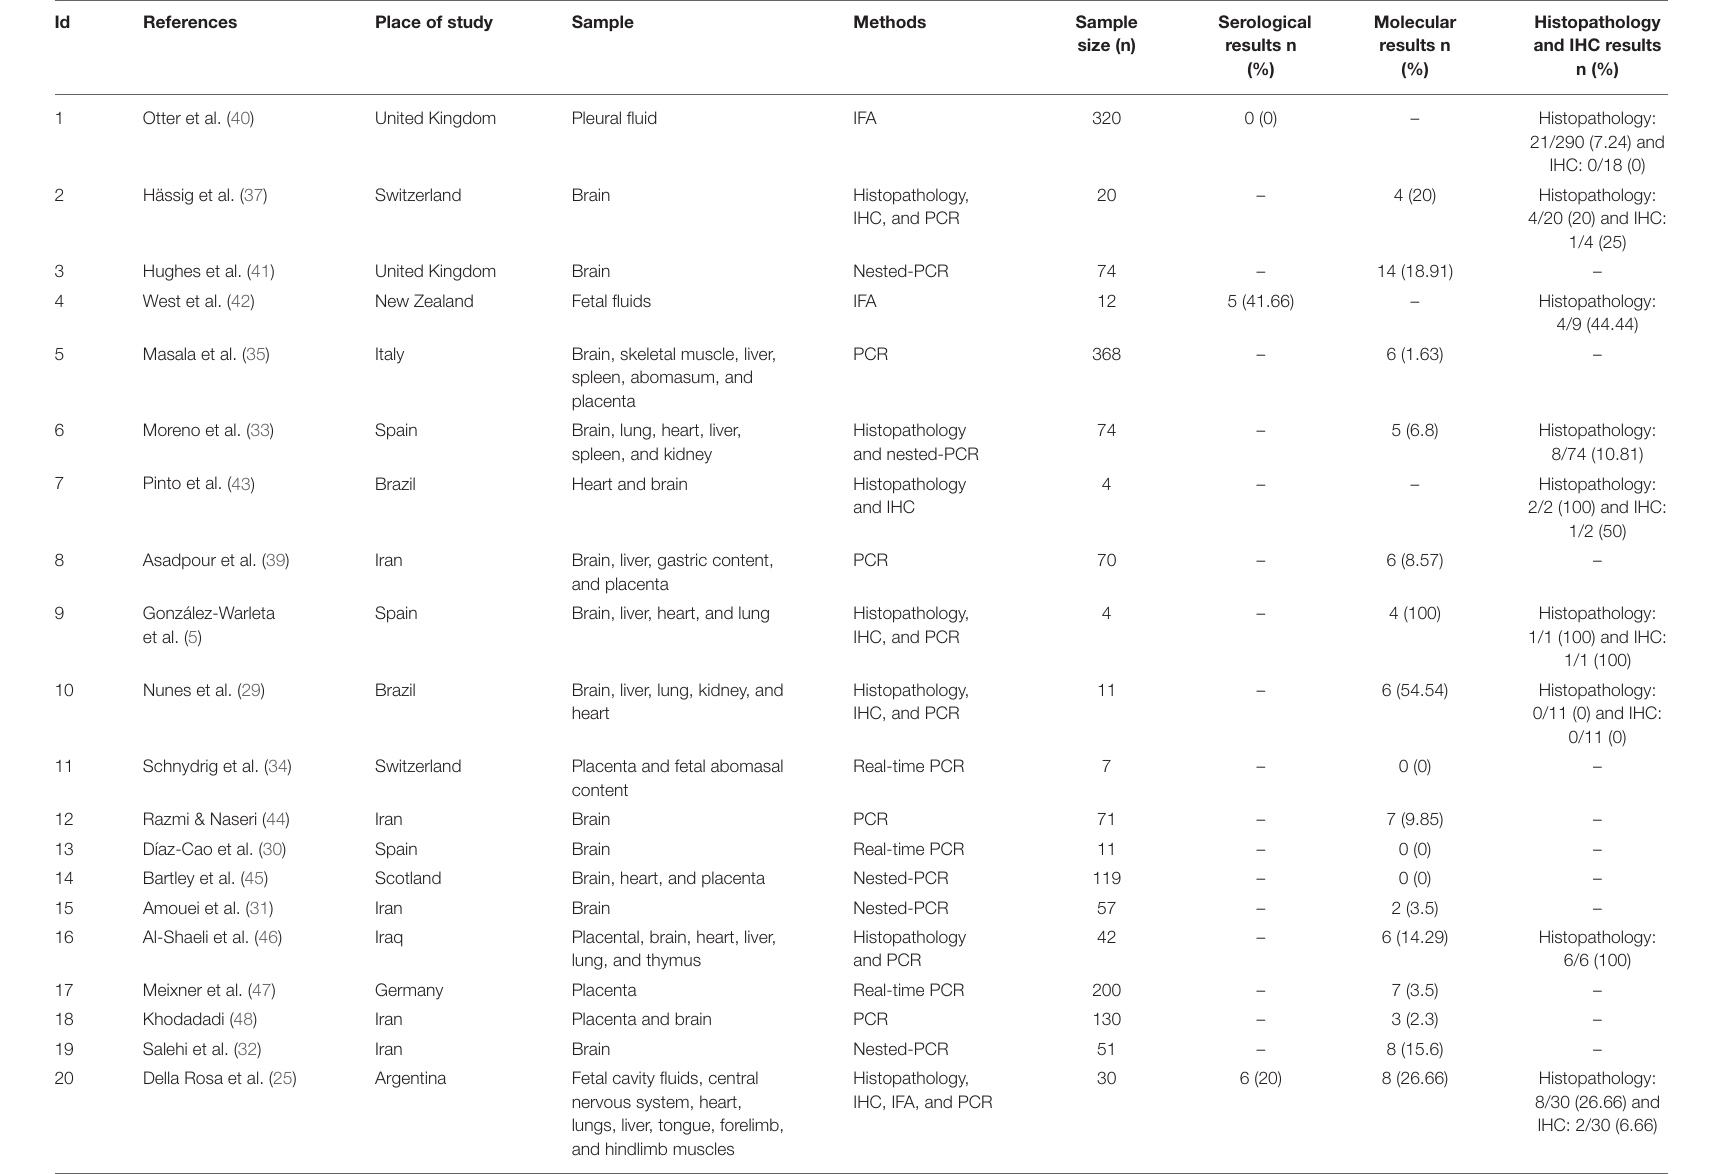
TABLE 2 | Characteristics of the included studies for prevalence of N. caninum in the aborted fetuses of